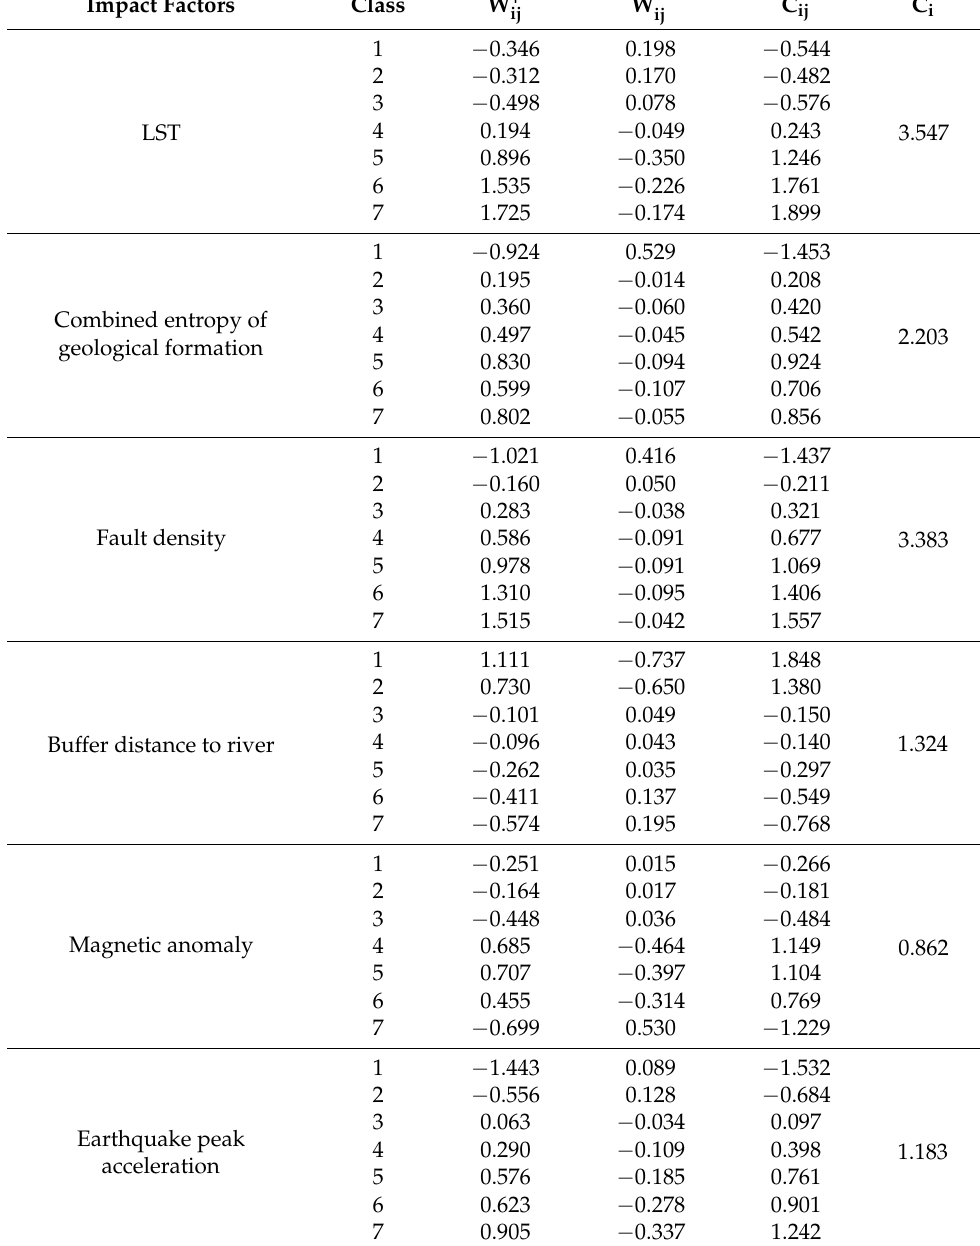
Table 5. Values of the weights of evidence for impact